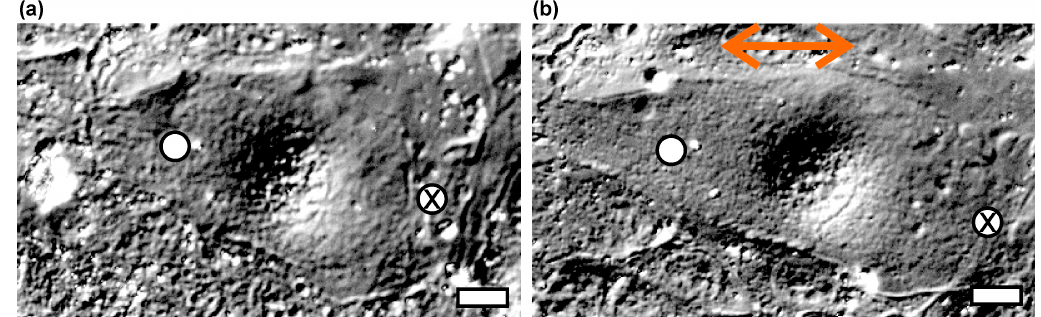
Figure 5. Differential interference contrast (DIC) images of a KtyI − / − cell in relaxed ( a ) and stretched ( b ) state. Strain was oriented horizontally (red double arrow) and amounted to 50%. White dots represent AFM indentations on cell lamellae, crosses on junctions. Scale bars: 20 µm.